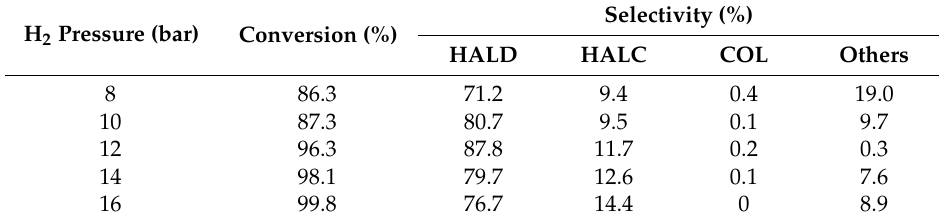
Table 4. Effect of H 2 pressure on activity over 0.2%Pd-1.2%Ni/SBA-15 a .